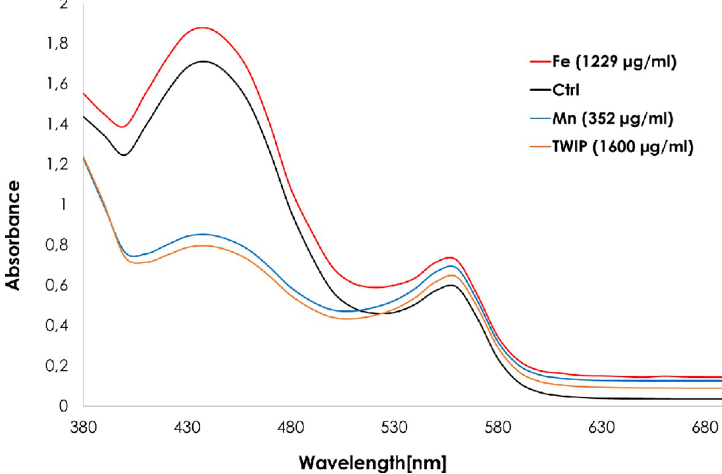
Fig 9. Full visible spectrum of the formazan dye formed in the presence of different particles. Different concentrations of Fe, Mn, TWIP steel or 316L steel powders were incubated with 10% WST-1 reagent. Then, ascorbic acid (0.5 mM) was added and the absorbance was measured at the full visible